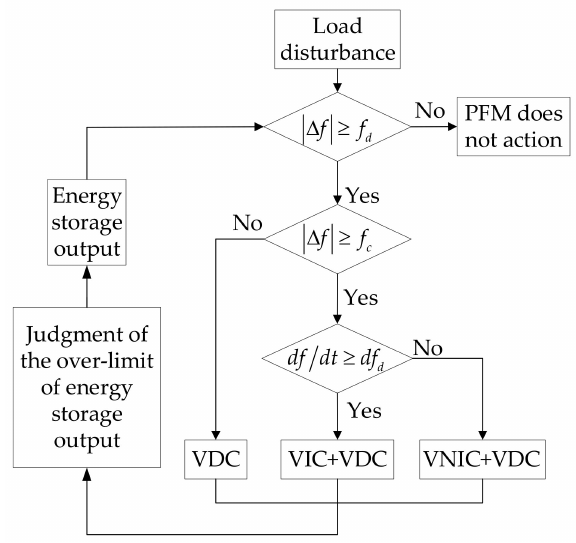
Figure 6. Control mode selection